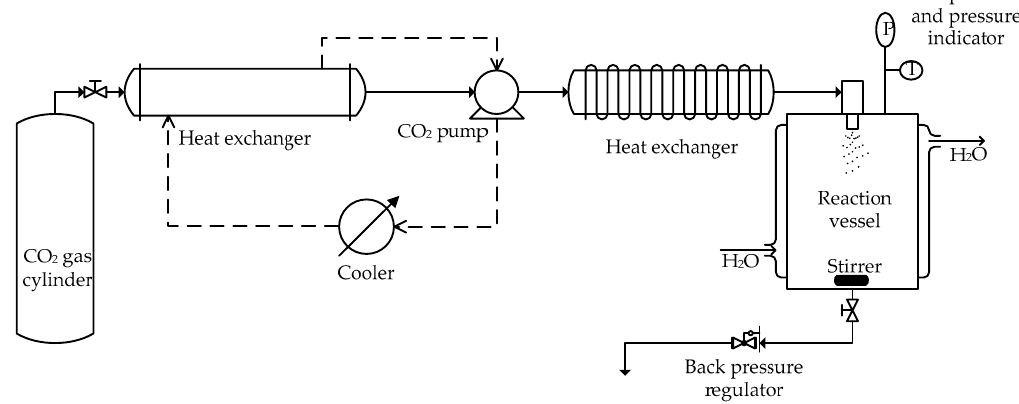
Figure 1. Schematic representation of the experimental apparatus for liposome preparation by the SCF-CO 2 method.